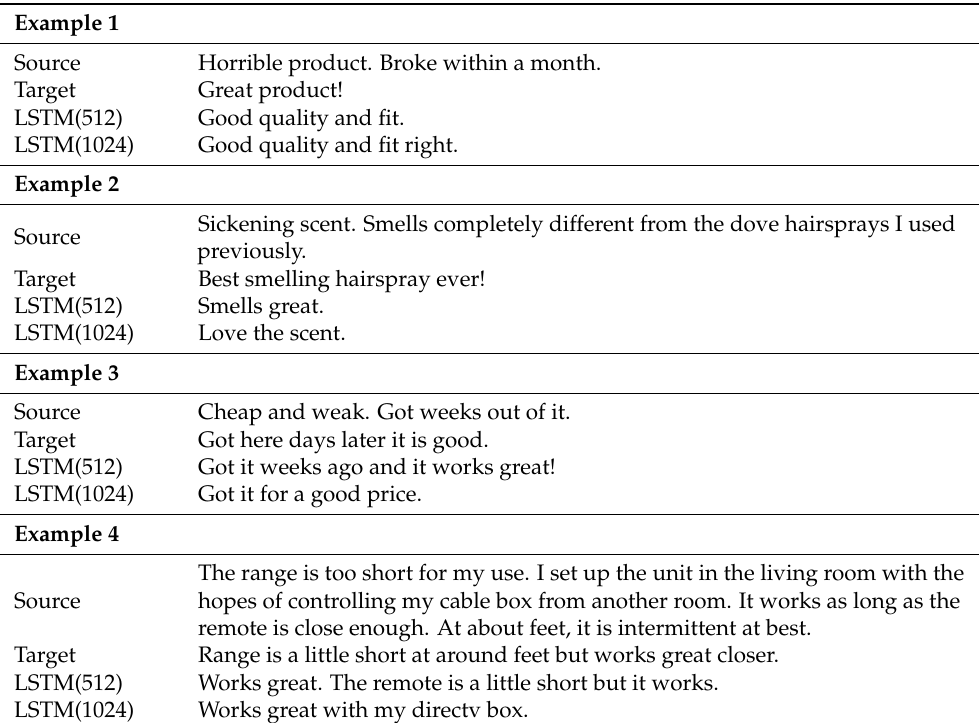
Table 6. Unsatisfied translated sentimental statements.